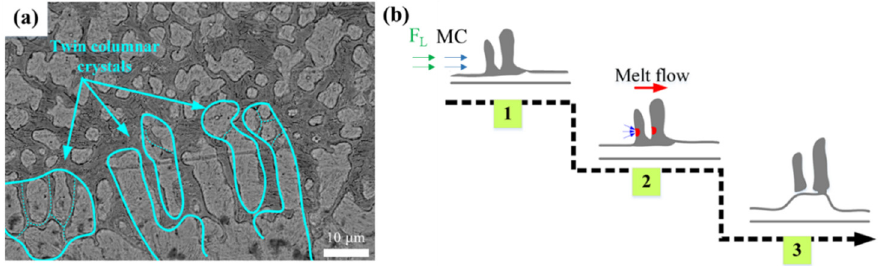
Figure 5. ( a ) Columnar dendrite fracture mechanism of coating B (20 mT) and its ( b ) schematic dia- gram.